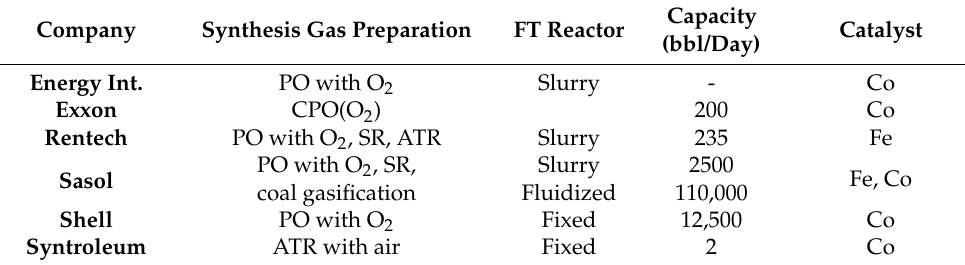
Table 7. Comparison of the major companies active in Fischer–Tropsch